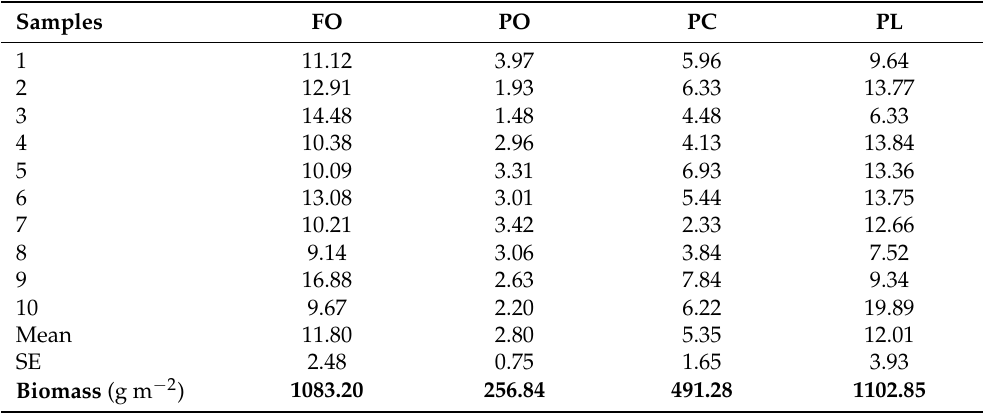
Table A1. Estimation of living mulch biomass from the weights (in grams) of 10 random samples (0.033 × 0.033 m) of each of the living mulches used in the